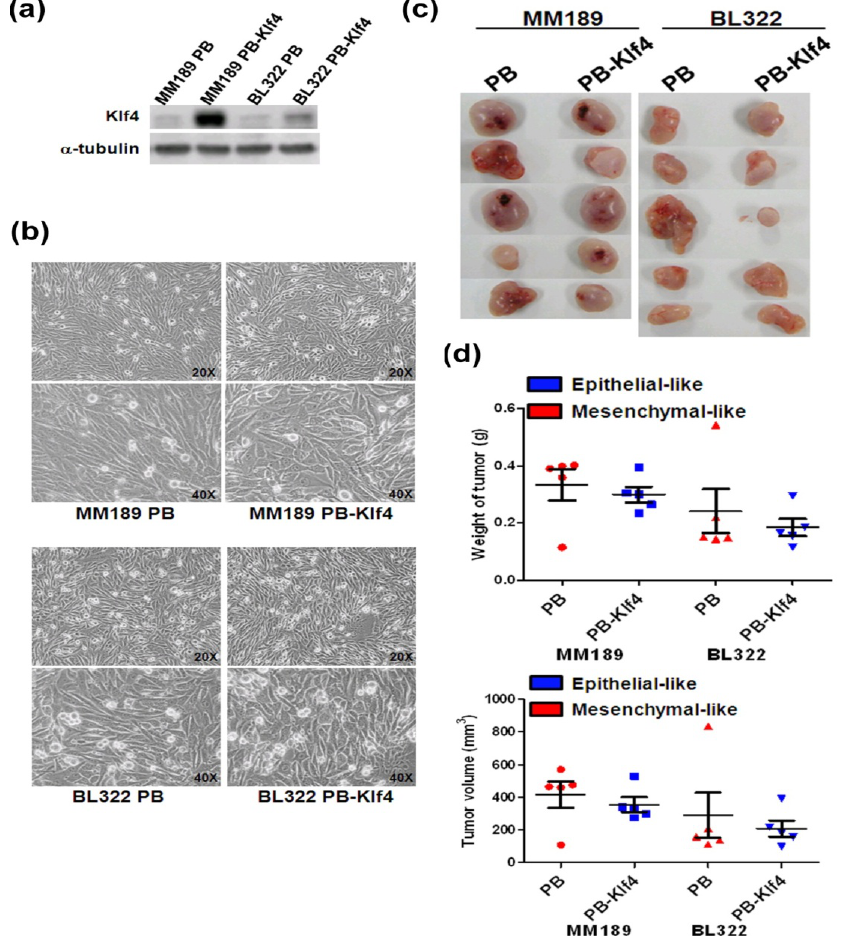
Figure 1. Comparison of tumor weight and volume in epithelial- and mesenchymal-like xenografted tumors. ( a ) Kruppel-like factor 4 (Klf4) and α -tubulin protein levels were detected in MM189 and BL322 with ectopic Klf4 expression (MM189 PB-Klf4/BL322 PB-Klf4) and their corresponding vector controls (MM189 PB/BL322 PB) on immunoblot assay. α -tubulin served as a loading control; ( b ) Phase contrast images of mesenchymal-like MM189 PB/BL322 PB and epithelial-like MM189 PB-Klf4/BL322 PB-Klf4 grown for 3 days on collagen-coated dishes were taken under a light field microscope with 200× and 400× magnifications; ( c ) Xenografted tumors generated from mesenchymal-like MM189 PB/BL322 PB (left flanks of animals) and epithelial-like MM189 PB-Klf4/BL322 PB-Klf4 cells (right flanks of animals); and ( d ) Quantification of xenografted tumor weight ( upper panel ) and volume ( lower panel